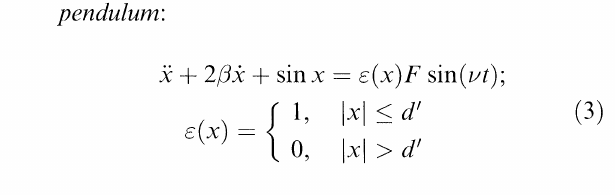
FIGURE 2 A typical trajectory of the kicked pendulum in the phase plane (x,